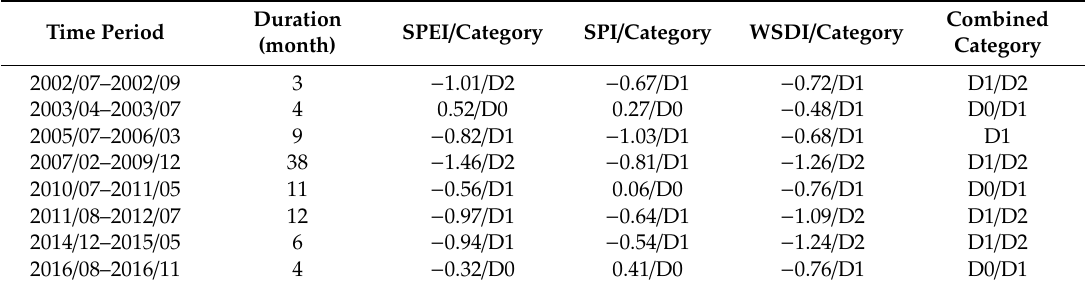
Table 3. Drought severity categories based on the SPEI, SPI, and WSDI of